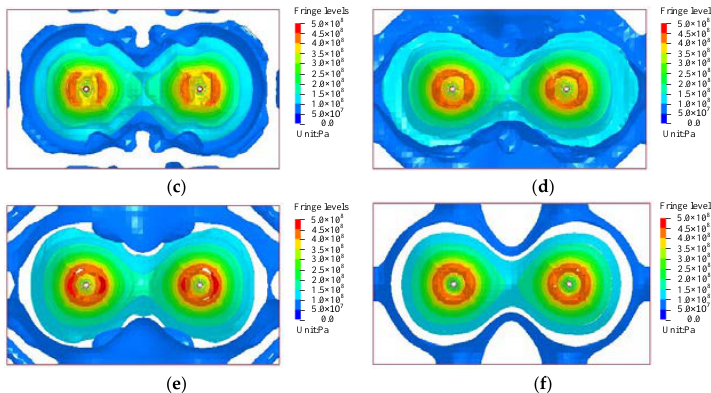
Figure 8. The evolution of the effective stress in the rock at the hole spacing of 1.0 m: ( a ) 39.886 μs; ( b ) 139.84 μs; ( c ) 299.51 μs; ( d ) 619.09 μs; ( e ) 1039.5 μs; ( f ) 1999.9 μs.